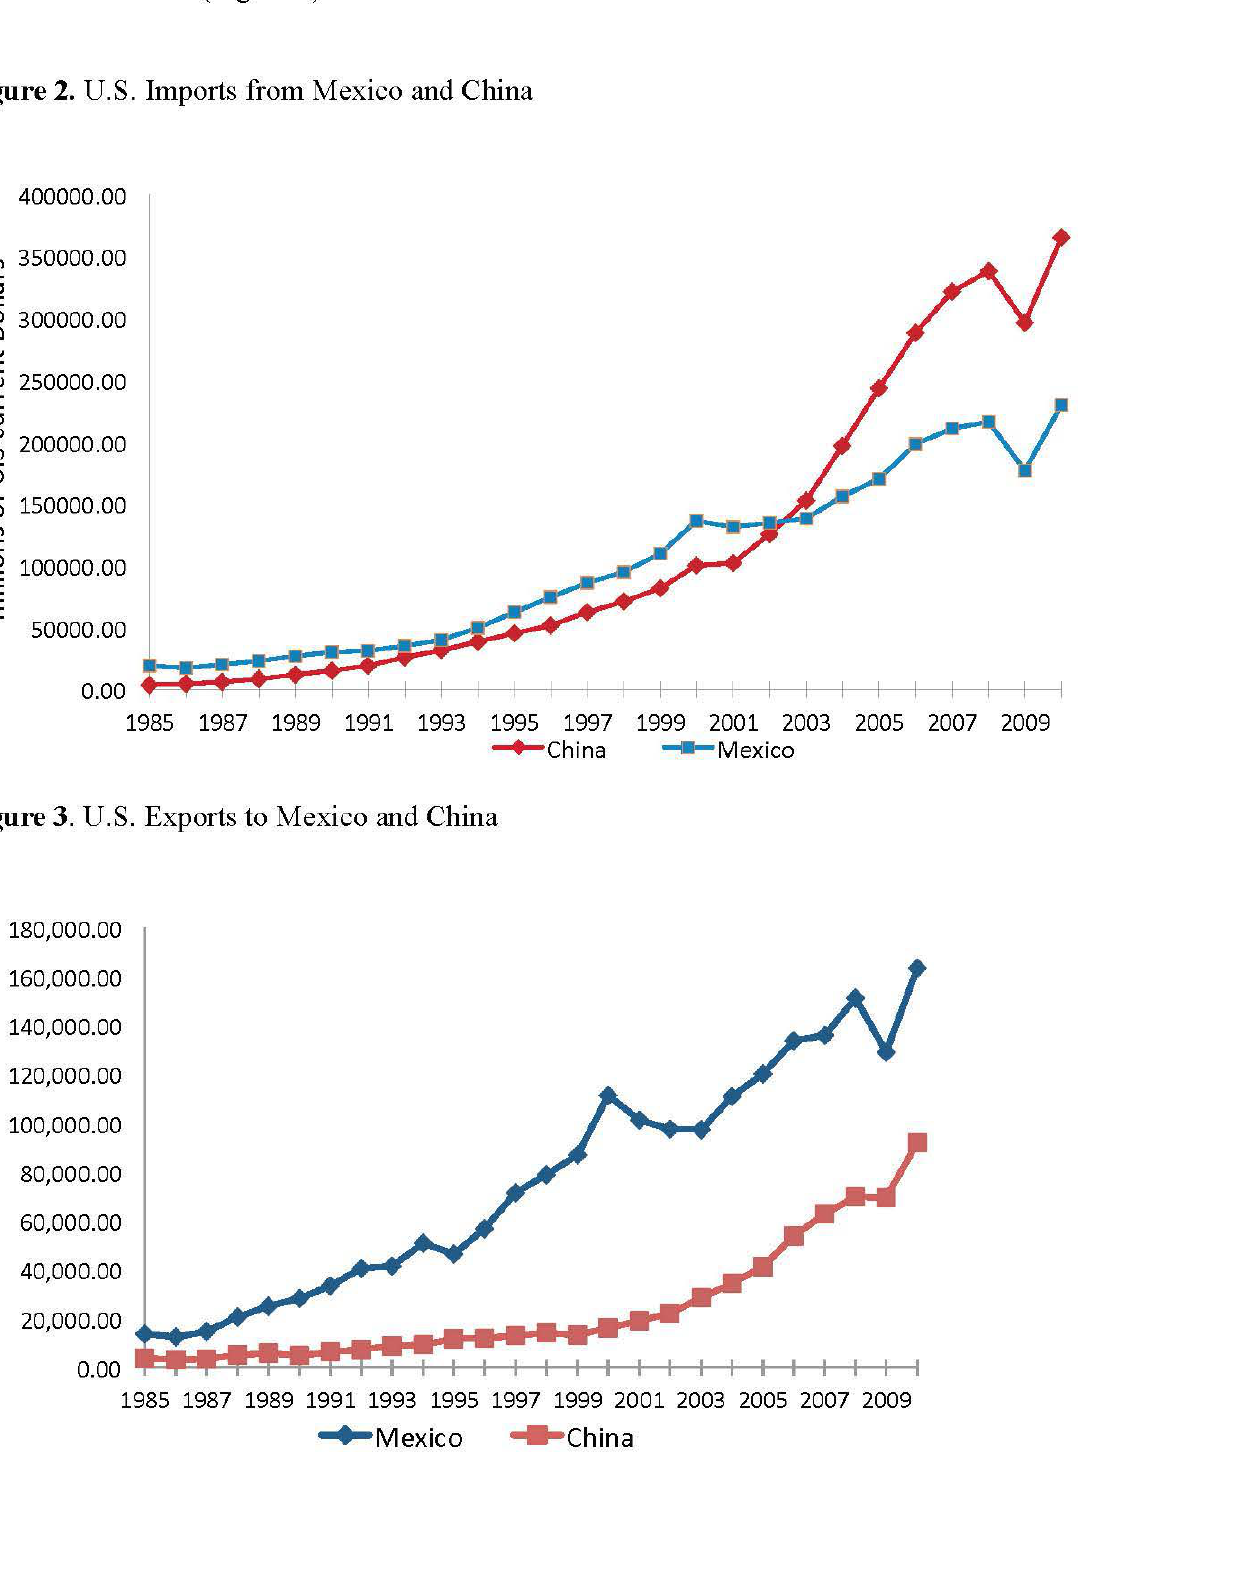
Figure 3. U.S. Exports to Mexico and